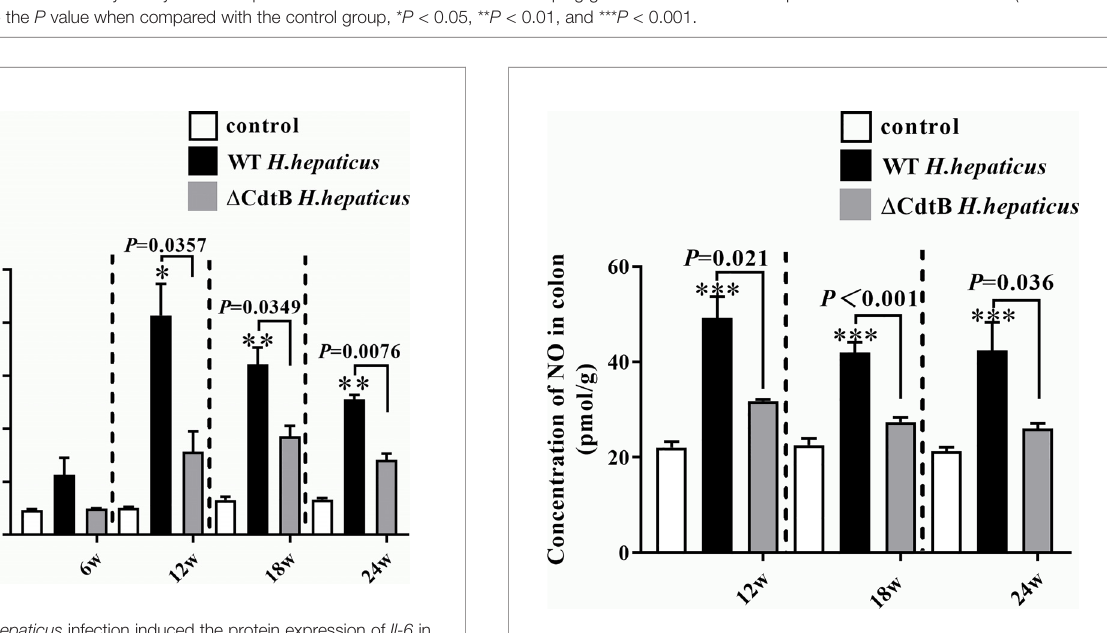
FIGURE 6 | H. hepaticus infection induced the content of NO. The content of NO in colon tissue was expressed as the concentration in pmol/g. Data are expressed as the means ± SEM (n = 5/group). ***means P < 0.001 as compared to